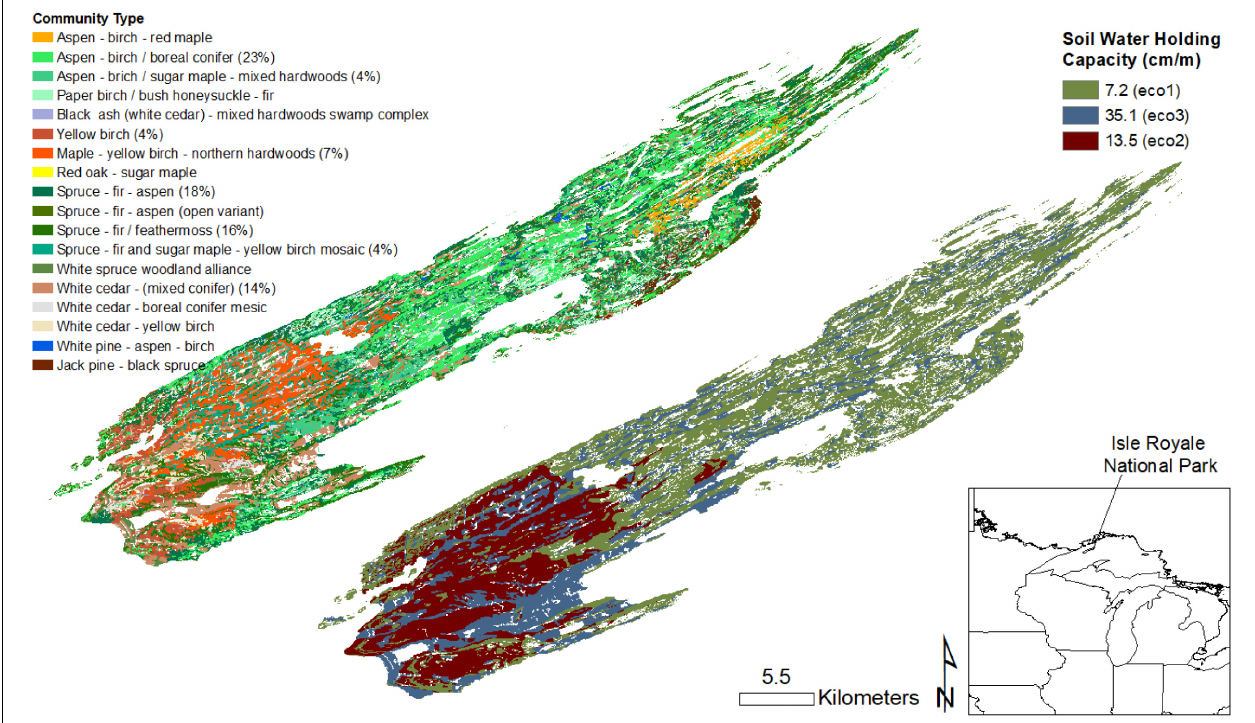
FIGURE 1 | Forest community types and soil water holding capacity representing initial conditions (c. 2006) at Isle Royale National Park. Percentage of total forest cover is provided for forest communities making up greater than 3% total forest cover. Forest plot data were imputed into the areas of similar forest community types to create the initial age and species distribution maps for modeling. Soil water holding capacity was used to delineate ecoregions, which influence rates of species establishment and